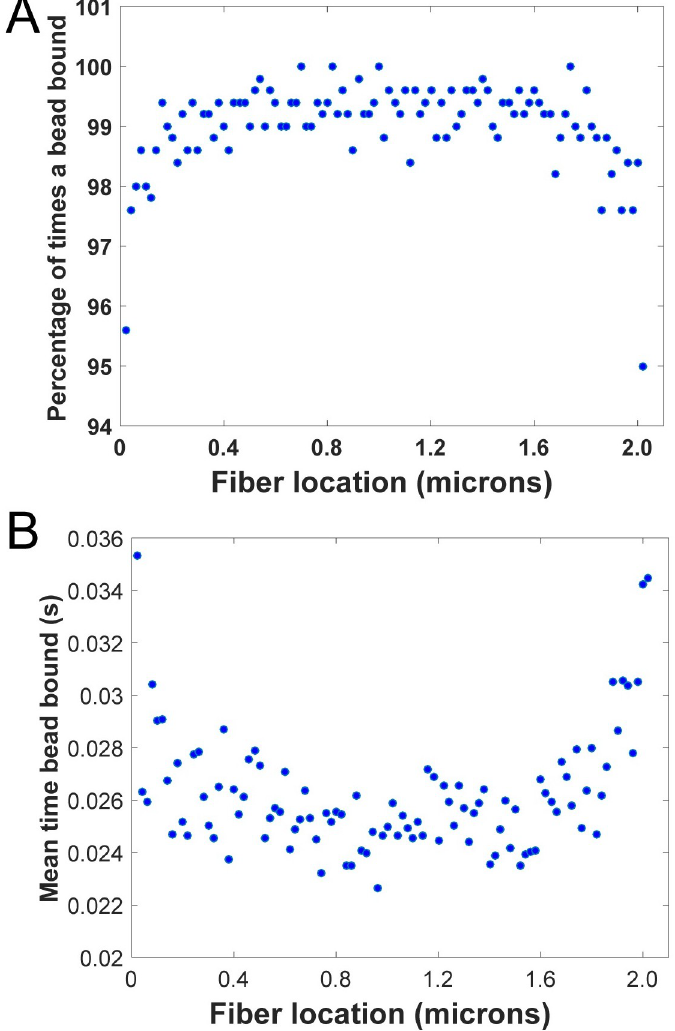
Fig 7. Simulation Results of Bead Diffusion and Binding: (A) The percentage of times a bead bound (out of 500 independent simulations) as a function of location along the fiber. Locations 0 and 2.0 are where the fiber connects to the ridges. (B) The mean time it took a bead to bind to the fiber (averaged over 500 independent simulations) as a function of location along the fiber. Locations 0 and 2.0 are where the fiber connects to the